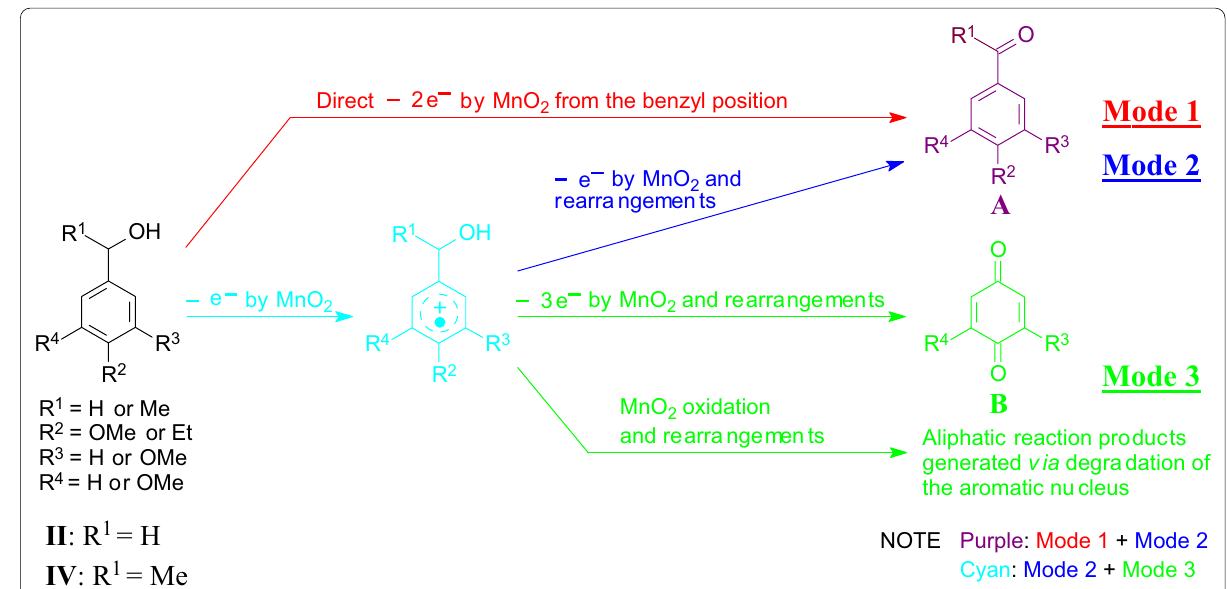
Fig. 2 Reaction modes proposed on the basis of the results in the MnO 2 oxidations of the C 6 -C 1 -type compounds in our recent report [4]